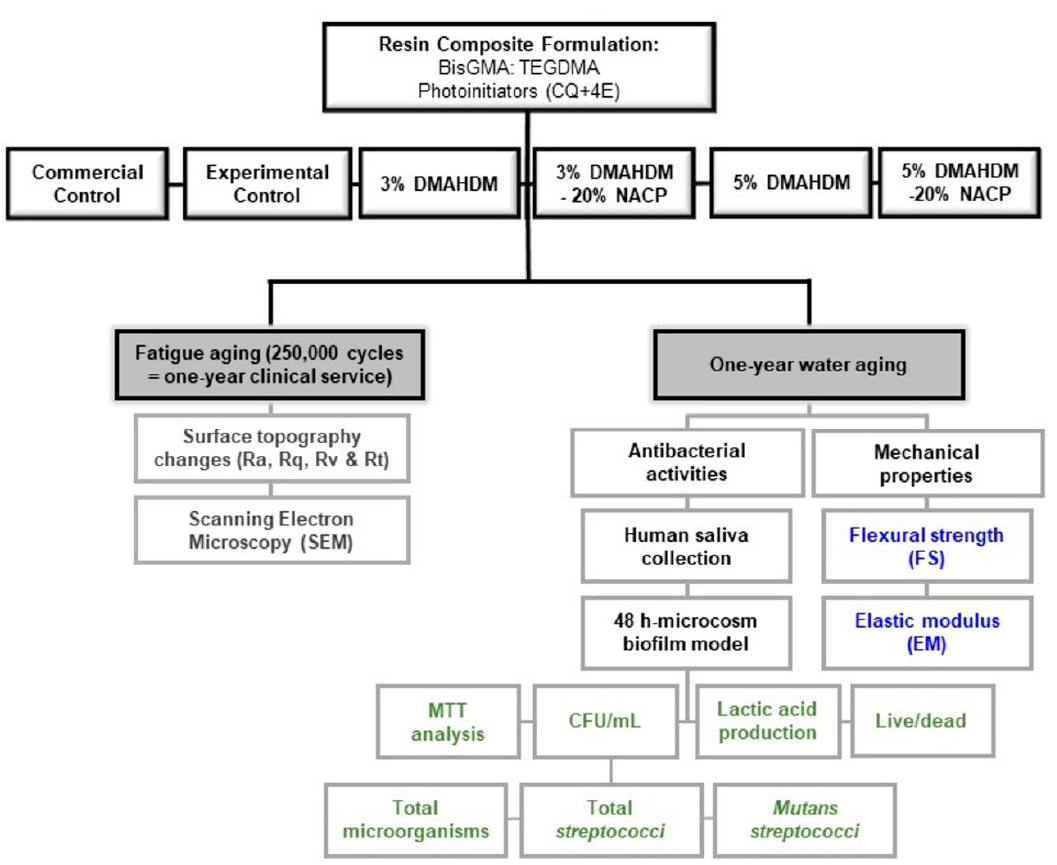
Figure 1. Flowchart of the experimental design proposed in this study. Different antibacterial formulations were designed. Following the aging, the mechanical properties were assessed via flexural strength, elastic modulus, and measurements of the topography changes following simulated wear. The antibacterial activity was analyzed by biofilm plate counting method, metabolic assay, colorimetric quantification of lactic acid, and Baclight ® bacterial viability assay.